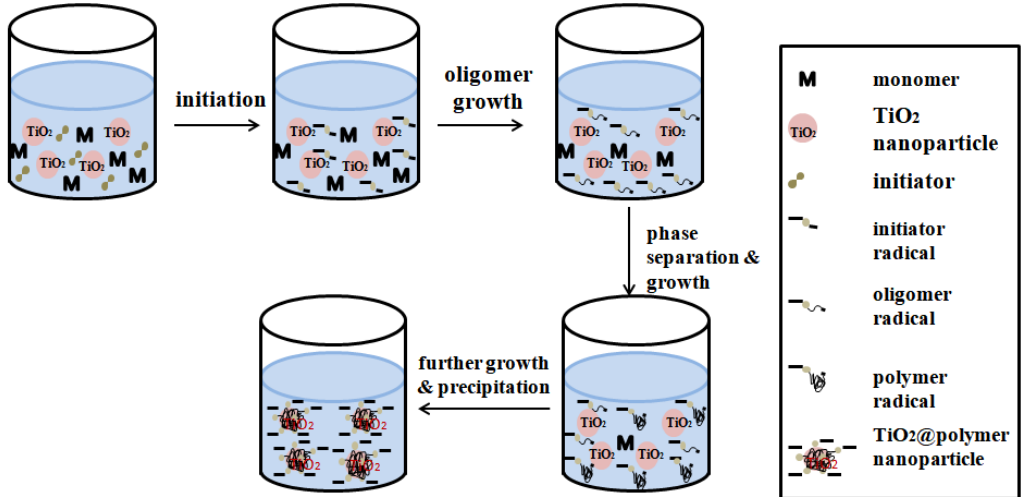
Figure 6. Schematic depiction of the seeded precipitation polymerization mechanism: (1) homogeneous solution of monomers, TiO 2 seeds and initiator molecules; (2) Thermal decomposition of the initiator leads to initiator radicals; (3) oligomer radicals’ growth; (4) growth of polymer radicals and phase separation; (5) precipitation of oligomer/polymer radicals onto the surface of the TiO 2 nanoparticle seeds. Adapted from ref [65].